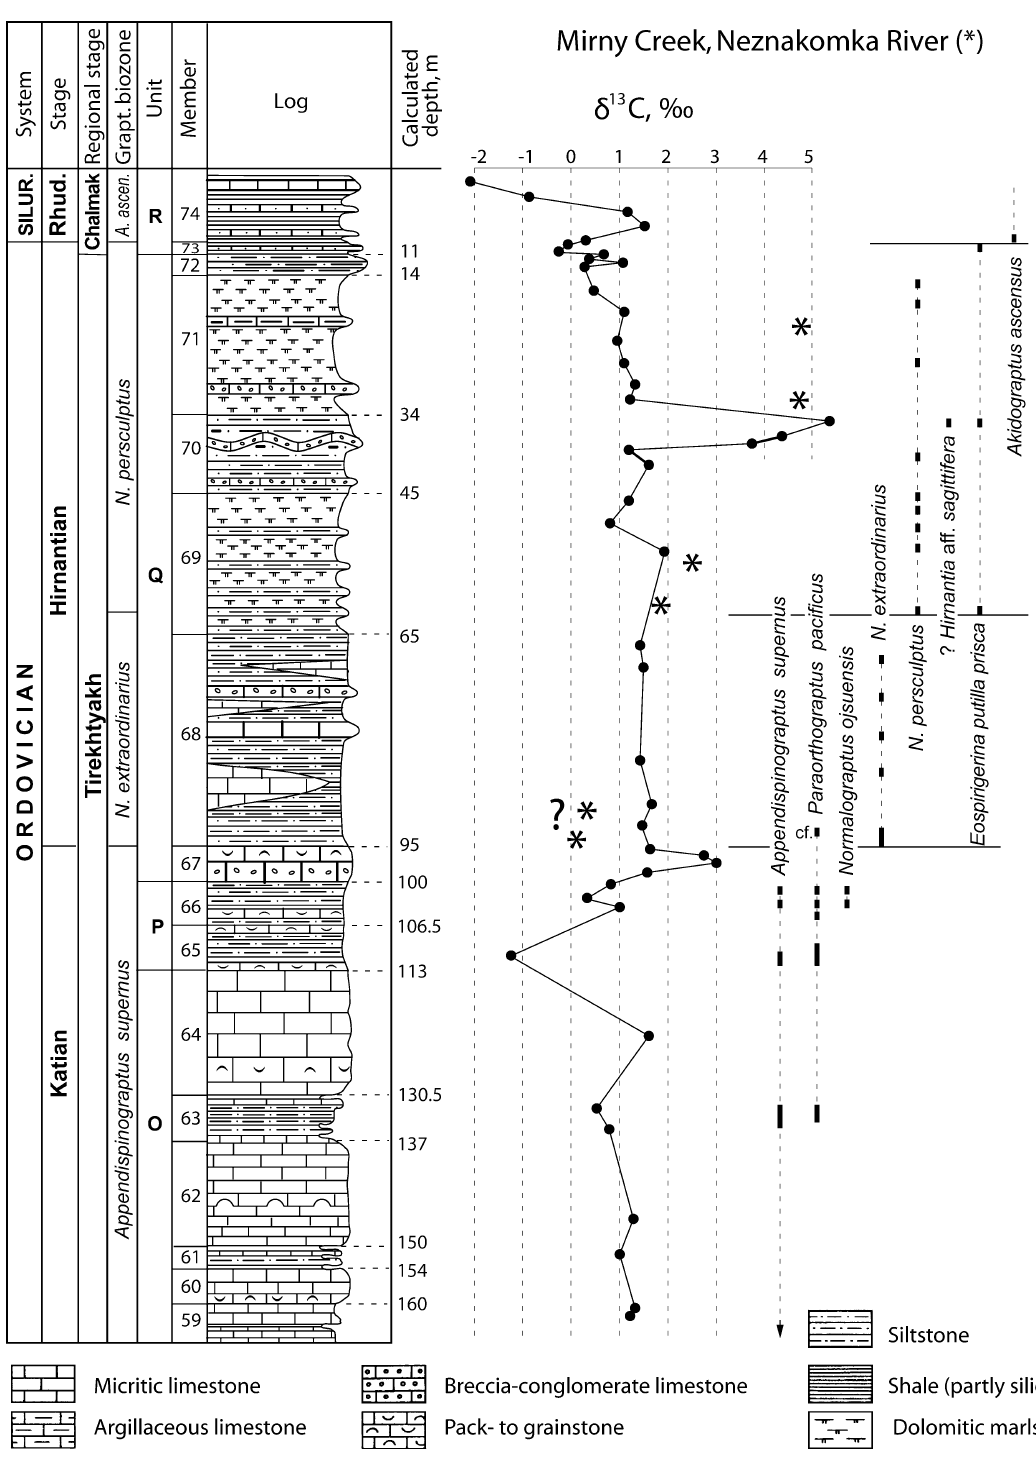
Fig. 3. Lithological log, stratigraphical subdivisions, fossil occurrences (all based on Koren ′ et al. 1983; Koren ′ & Sobolevskaya 2008) and carbon isotope trend measured in the Ordovician(cid:150)Silurian rocks of the Mirny Creek section with additions from the Neznakomka River outcrops. Note the question mark at the two lowest Neznakomka samples casting doubt about the